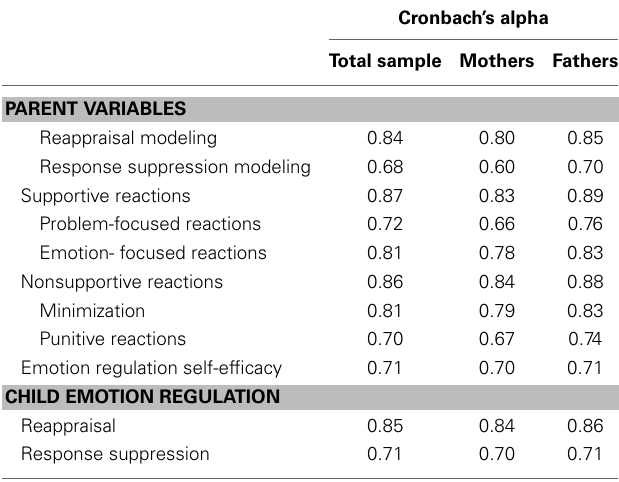
Table 1 | Internal consistencies of all scales used in the